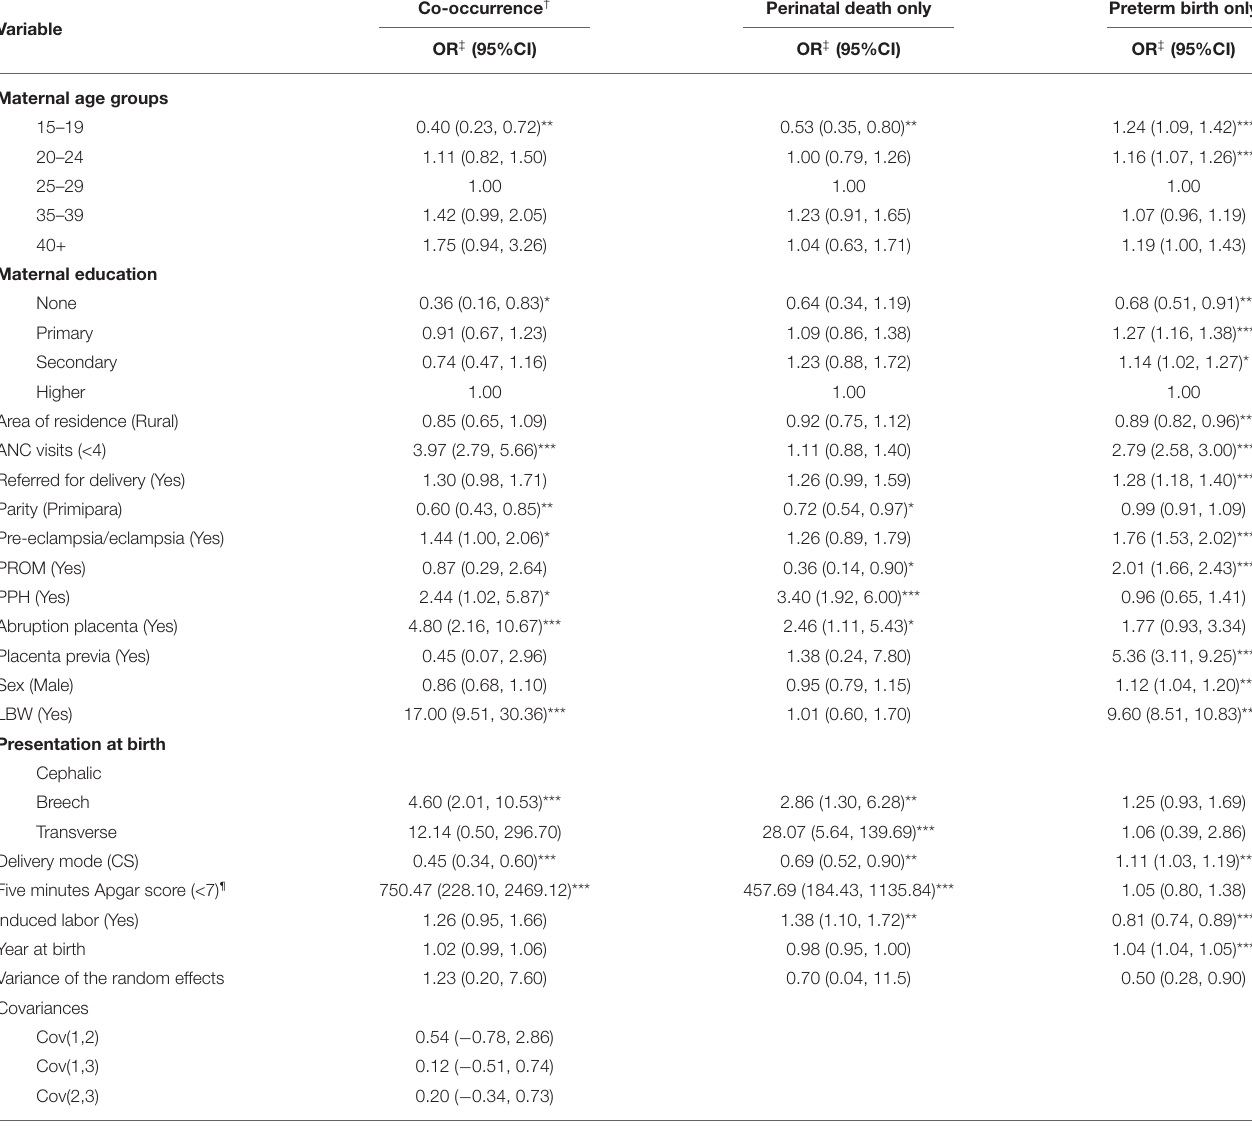
TABLE 5 | Predictors of independent and co-occurrence of preterm birth and perinatal death using multinomial regression model with separate but correlated random effects ( N = 51,493).